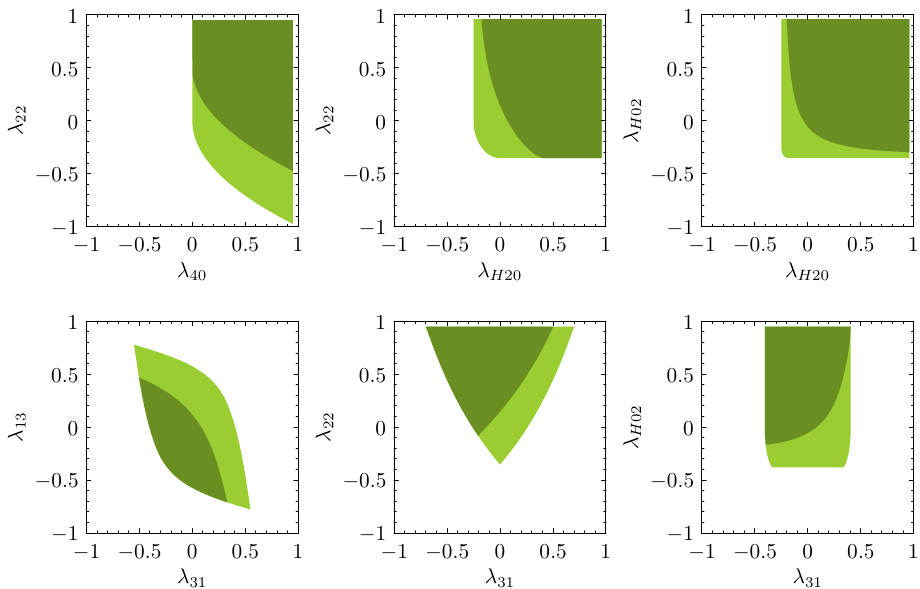
= λ = λ = λ = 0, except for plots where these couplings λ H 20 H 02 31 13 vary. Both light and dark green regions are allowed for for λ H 11 = 0, while only the dark green region is allowed for λ H 11 = 0 . 5